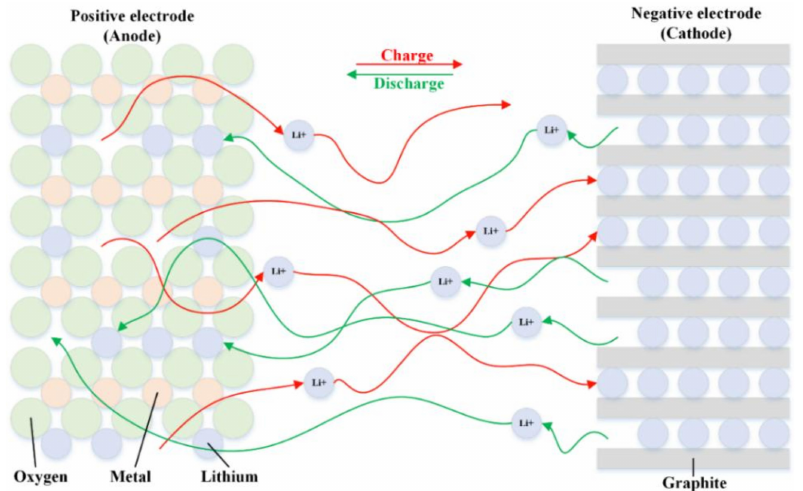
Figure 3. Schematic diagram of the Li-ion battery during the charging and discharging condition.